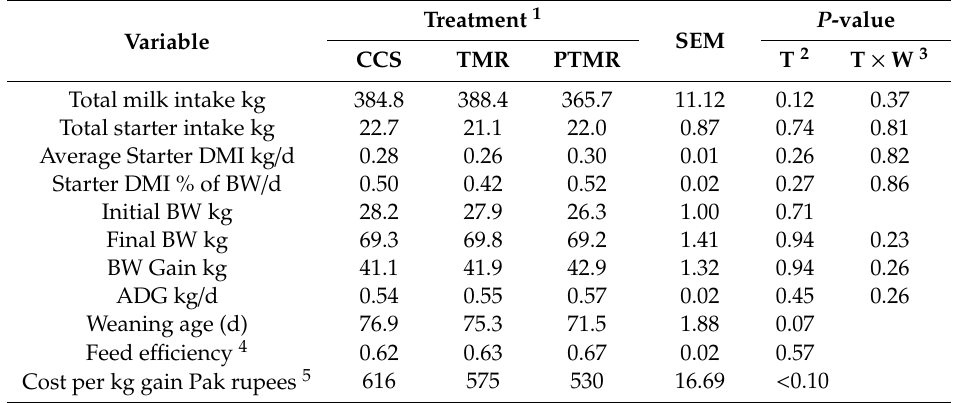
Table 3. Effect of feeding calf starter and oat hay as TMR or in pelleted form on preweaning performance of crossbred calves (values are least square means).